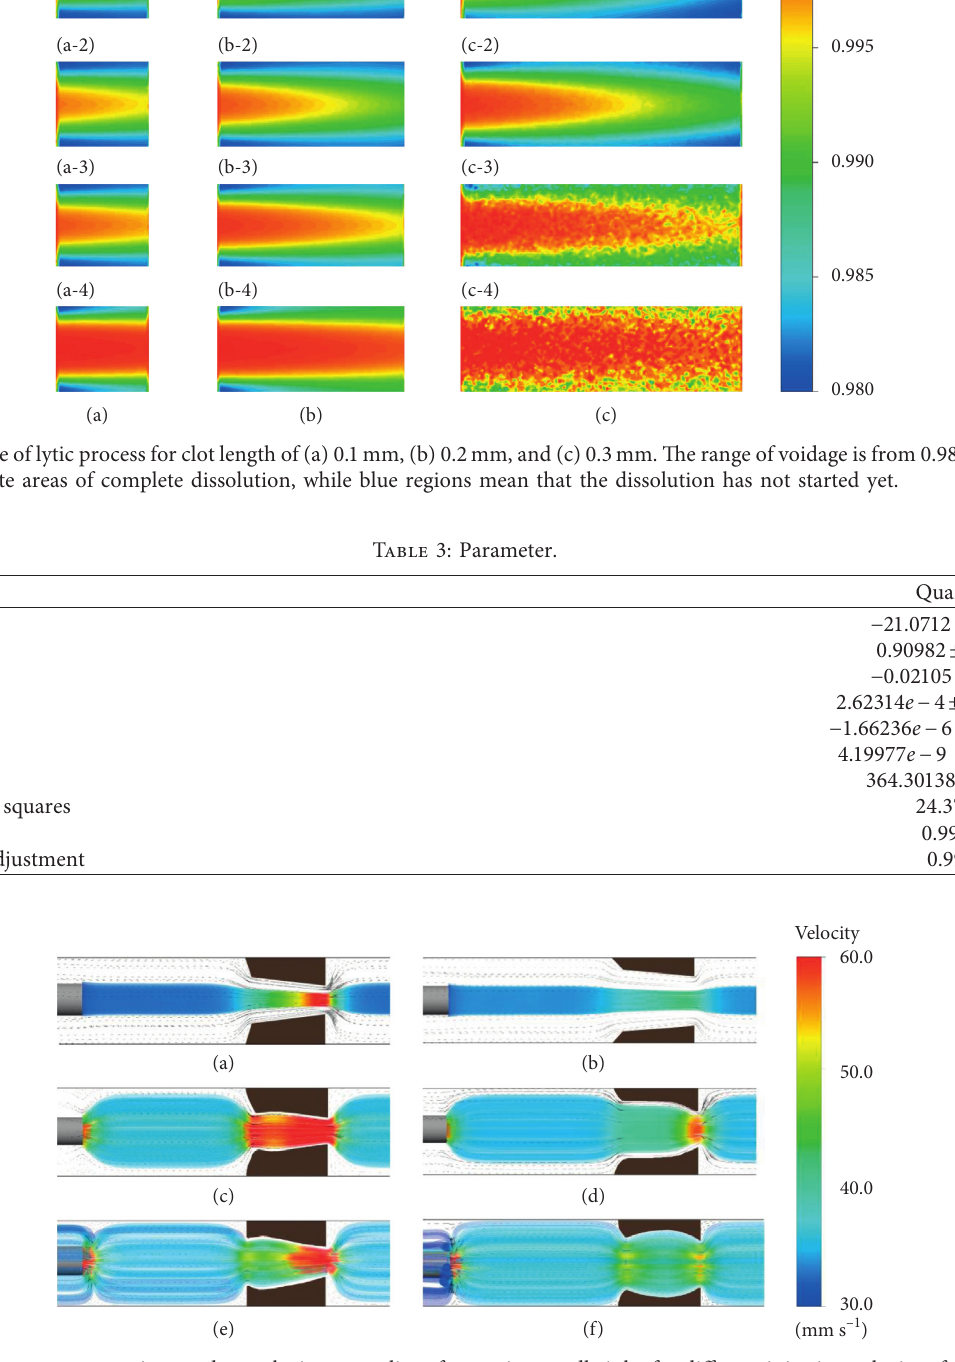
Figure 8: The flow vectors superimposed on velocity streamlines from microneedle inlet for different injection velocity of 20 mm/s (a, b), 50mm/s (c, d), and 80 mm/s (e, f). The red regions show areas of velocity of 60.0mm/s or higher, while the blue regions denote areas of velocity of 30mm/s or lower.